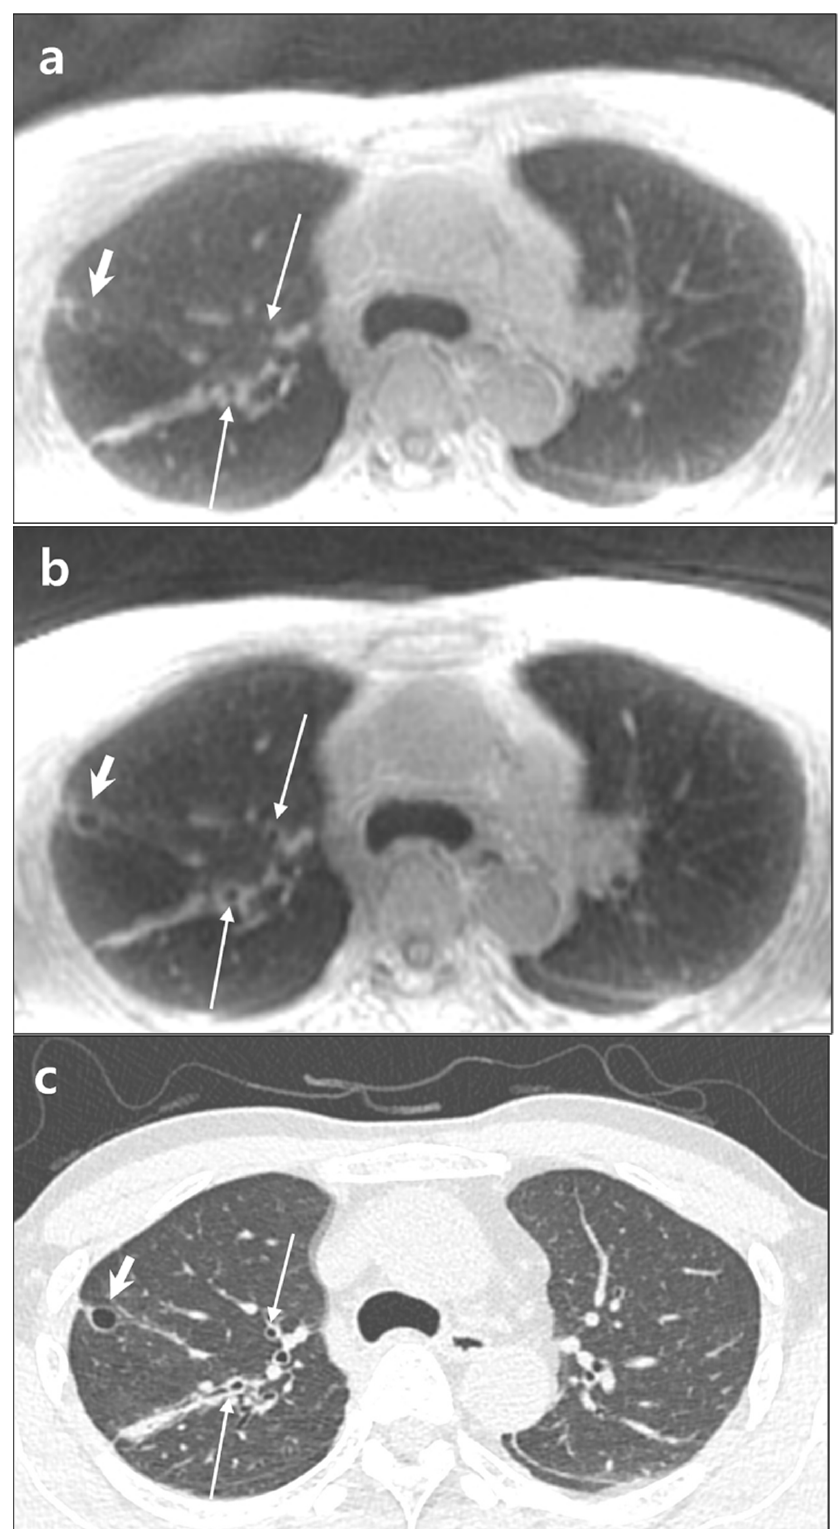
Figure 2. A 55-year-old male with lung cyst in the right upper lobe. Note signal difference between lung parenchyma and cyst (short arrows) and visualization of peripheral bronchi (thin arrows) in ZTE-CAA ( a ) and ZTE-AIR ( b ). Chest CT image ( c ) is presented as reference. ZTE-CAA, zero echo time lung MR image using conventional anterior array coil; ZTE-AIR, zero echo time lung MR image using adaptive image receive coil.